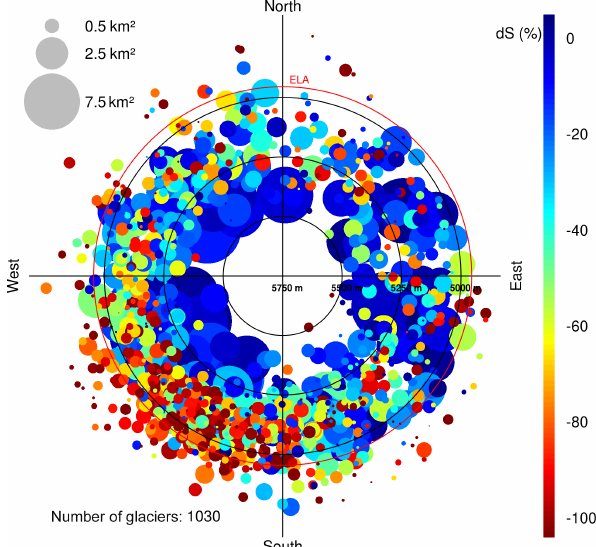
Figure 3. Polar plot of relative area changes (dot colour) in subre- gion R1 in the period 2000–2016 of individual glaciers. Dot size: glacier size in 2000; radius: median elevation; orientation: mean as- pect. Red circle: equilibrium line altitude (ELA); see also Table S3. Plots for other subregions and time intervals are provided in the Supplement.